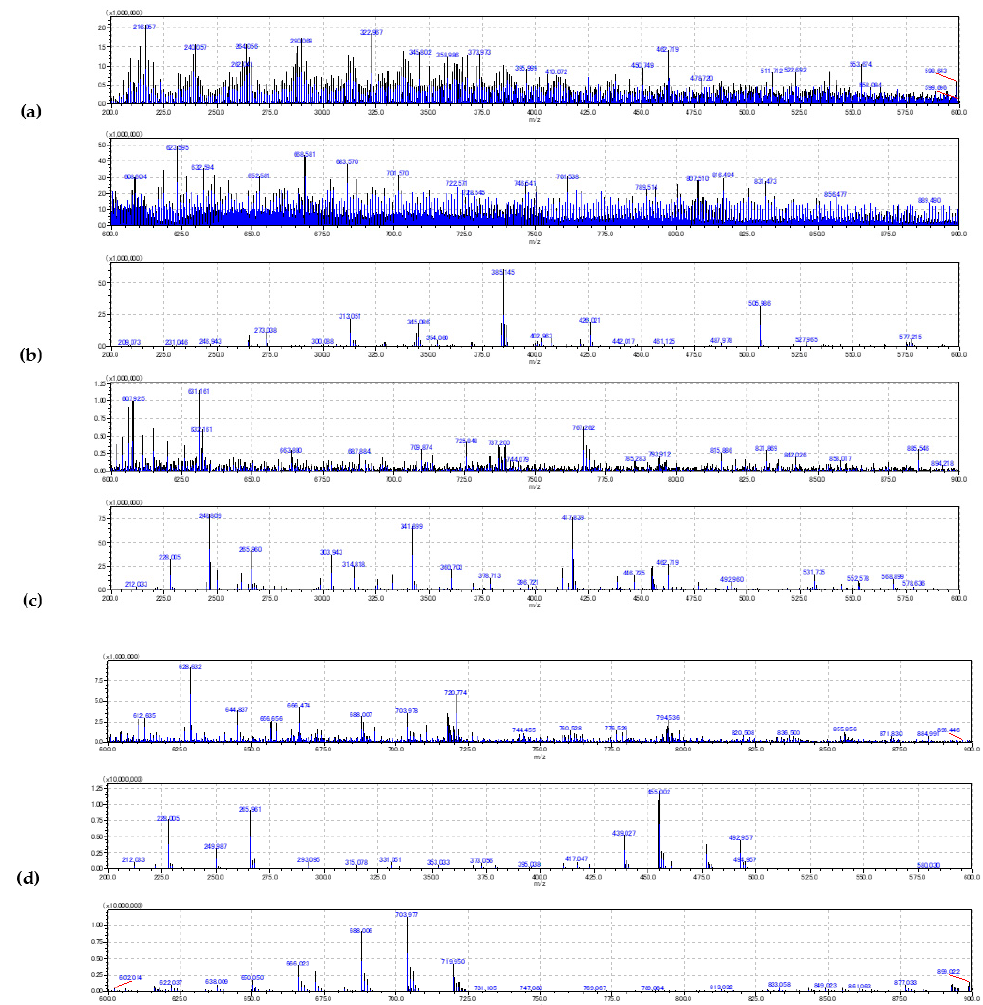
Figure 3. Comparison of total ion count (TIC) normalized spectra (upper: m / z 200–600 and lower: 600–900 Da) averaged over all pixels recorded using the selected D0 and D1 instrumental settings: ( a ) D0 settings and 9–aminoacridine (9AA) matrix/negative ionization, ( b ) D1 settings and 9AA matrix/negative ionization, ( c ) D0 settings and α -cyano-4-hydroxycinnamic acid (CHCA) matrix/positive ionization, and ( d ) D1 settings and CHCA matrix/positive ionization. LASER shot diameter and accuracy are of critical importance for the reliable generation of MSI and individual cell chemical composition assessment. Figure 4 shows regions of interest (ROI) designated by yellow squares before and after the MSI was performed using the selected D0 and D1 settings.